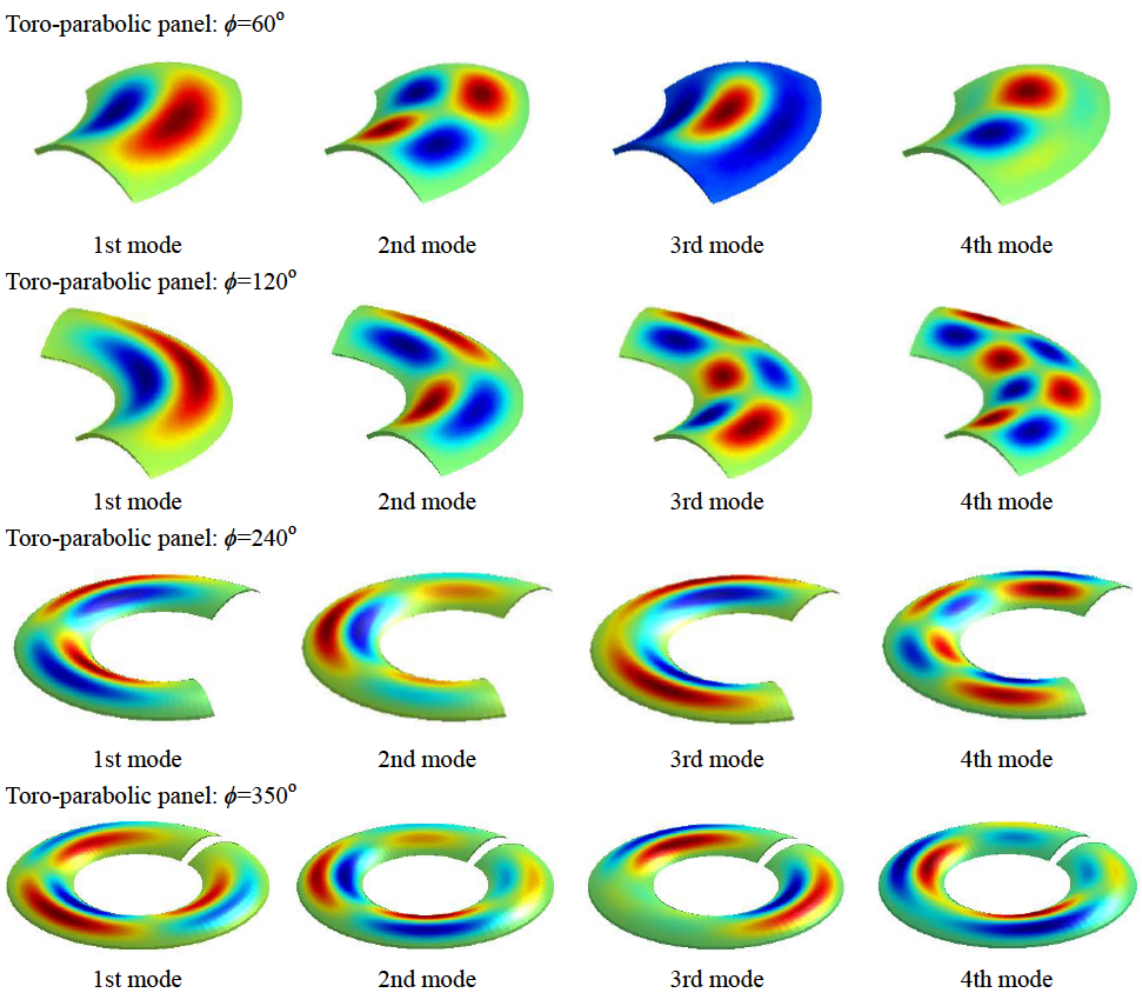
Figure 4: Mode shapes of the Toro-parabolic panel with CE 1 CE 1 boundary condition.